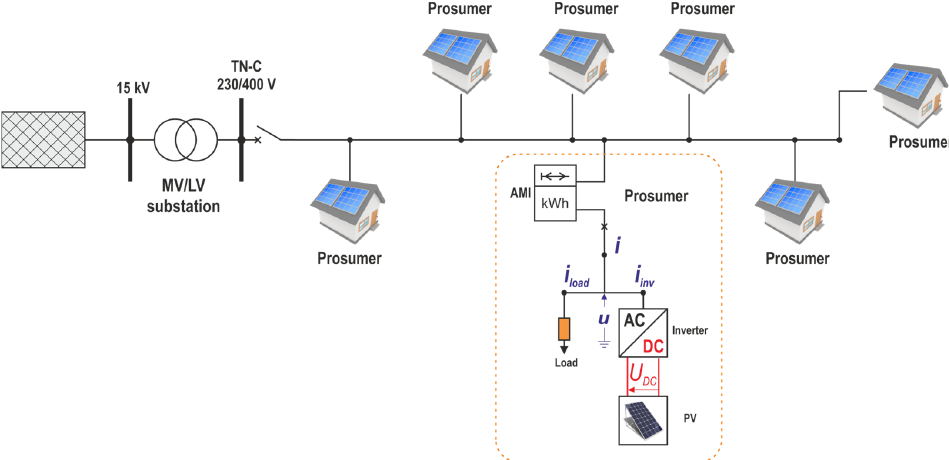
Figure 1. Diagram of a prosumer installation coupled with a distribution network.